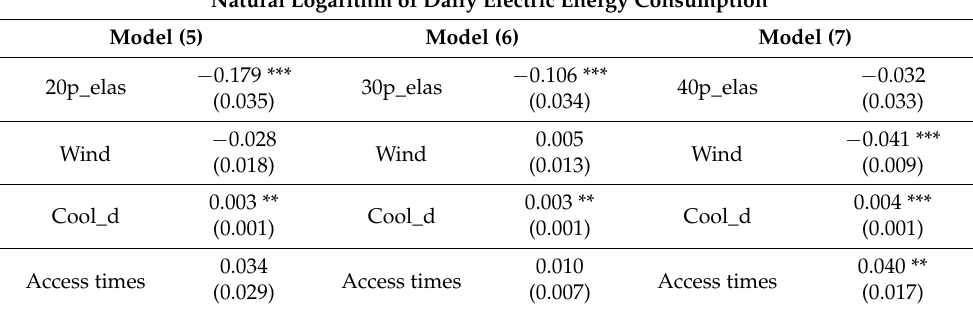
Table A3. Price elasticity of demand regression